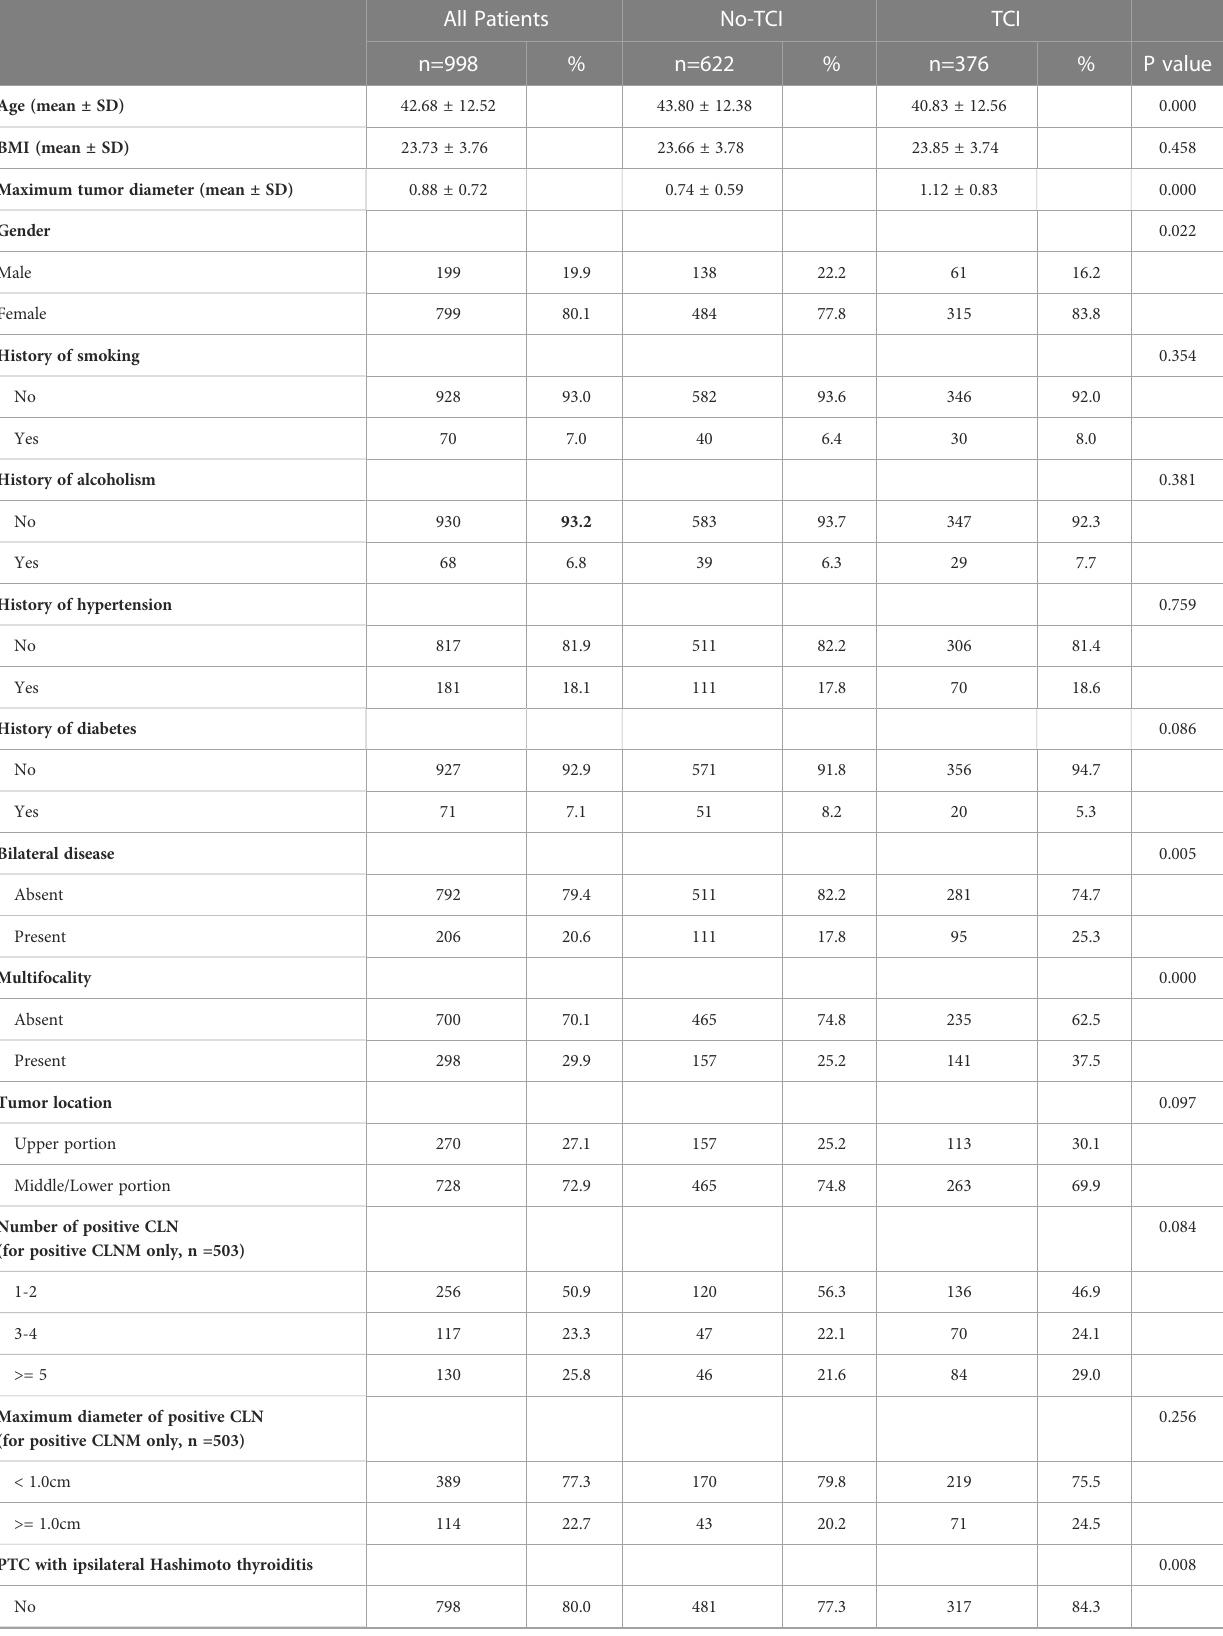
TABLE 1 The clinicopathological characteristics of all patients.